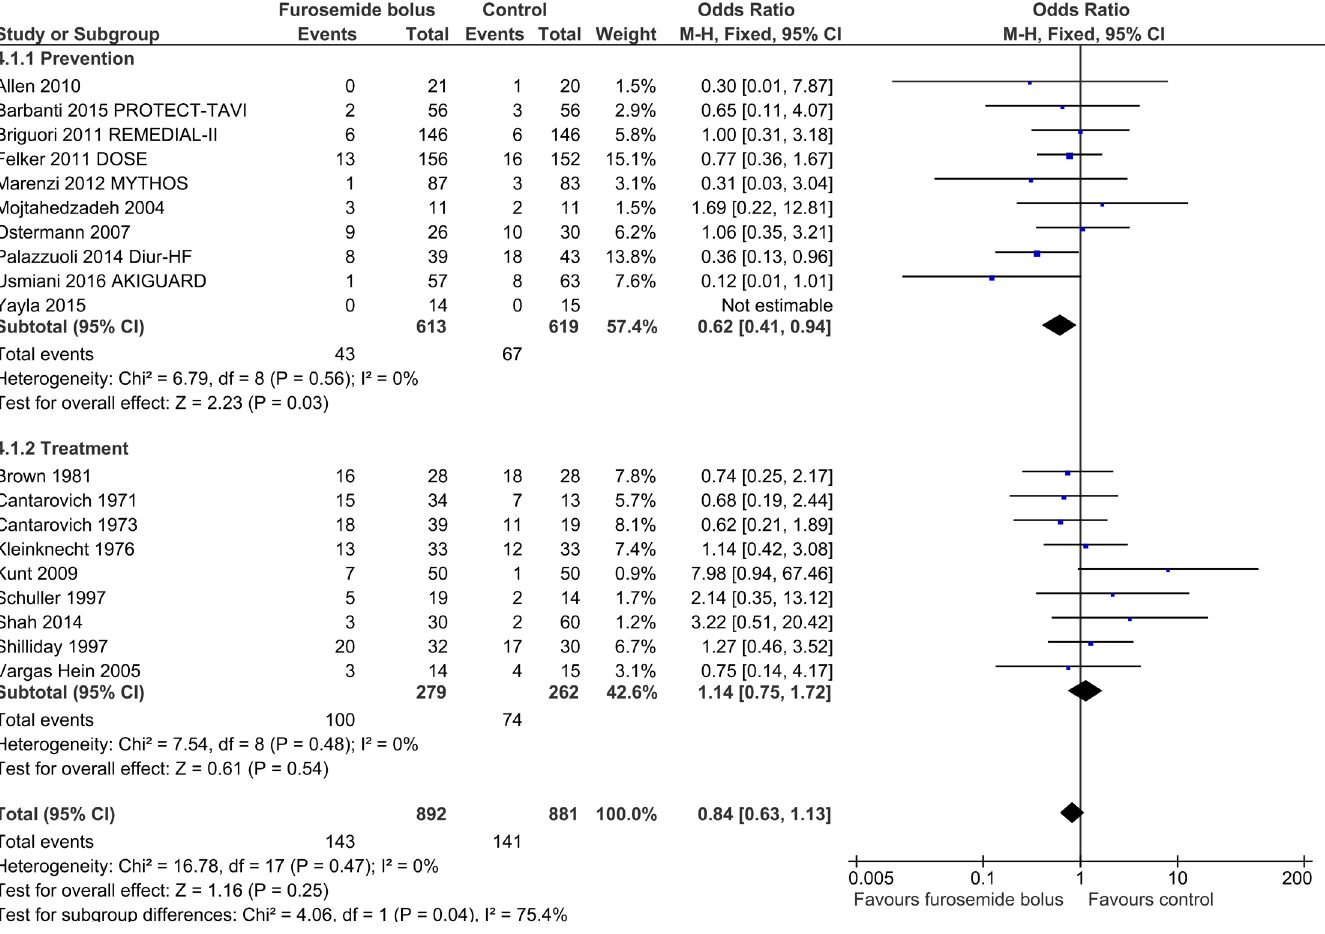
Fig 3. Furosemide prevention VS treatment